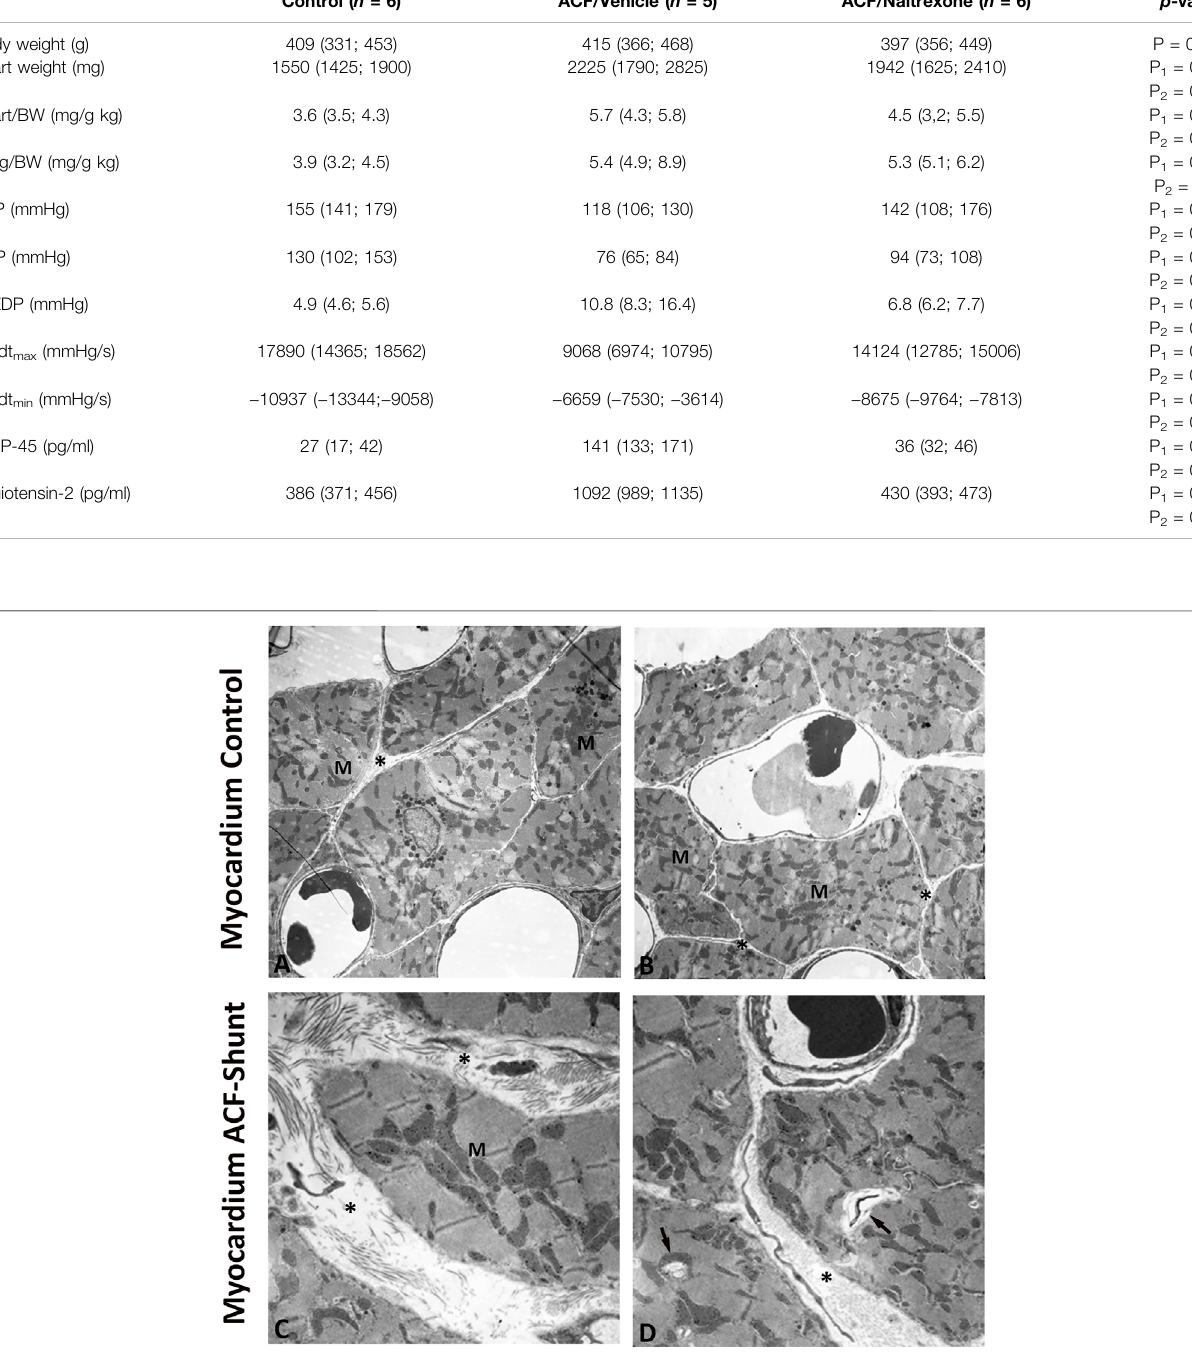
Frontiers in Pharmacology |